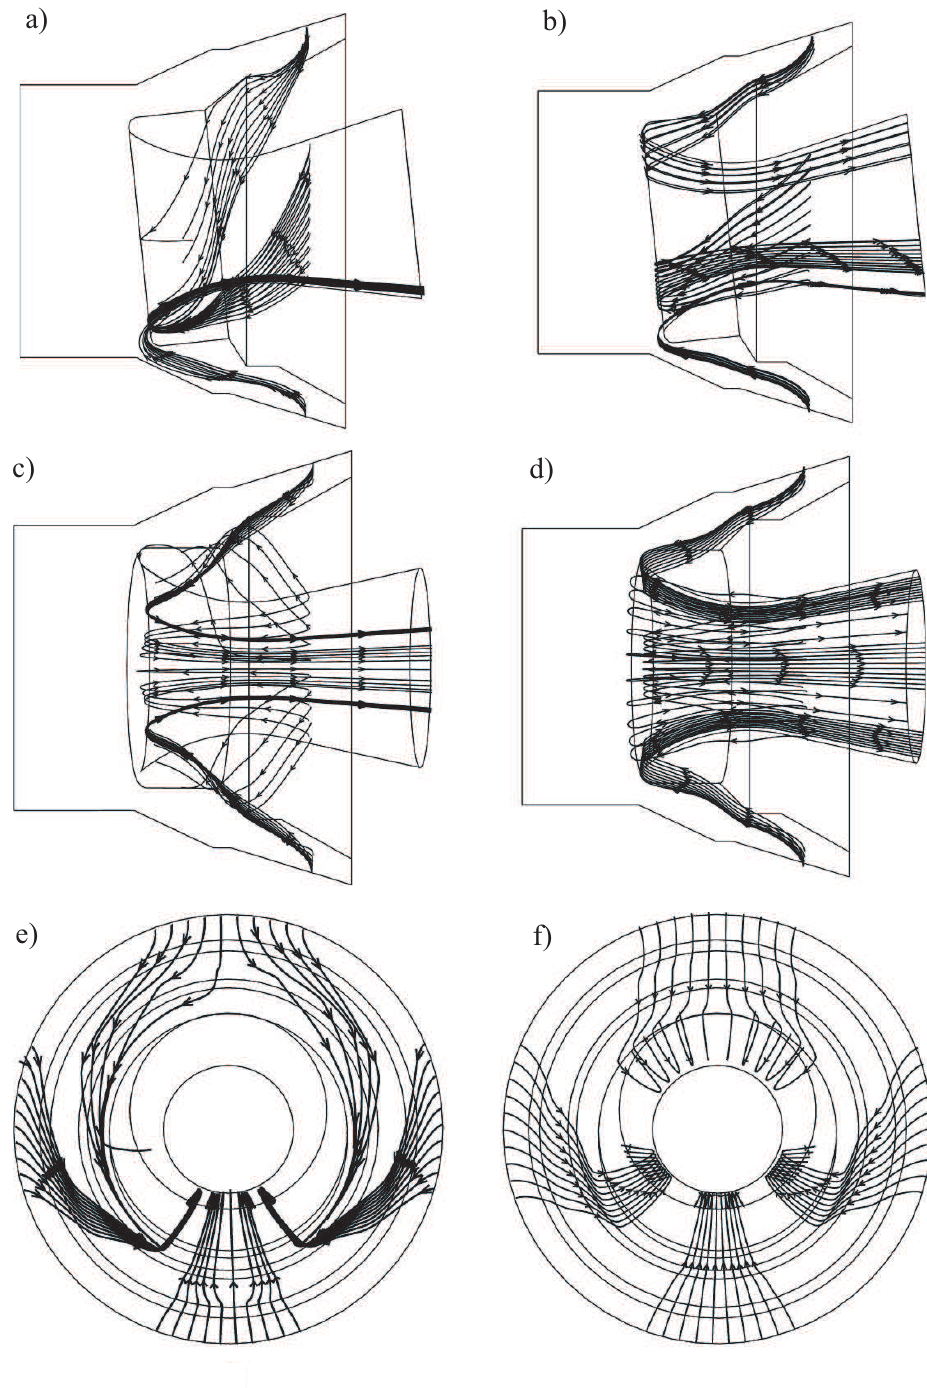
Figure 22. Solutions computed with unsteady formulation ( a , c , e ) and steady formulation ( b , d , f ) for α = 6 ◦